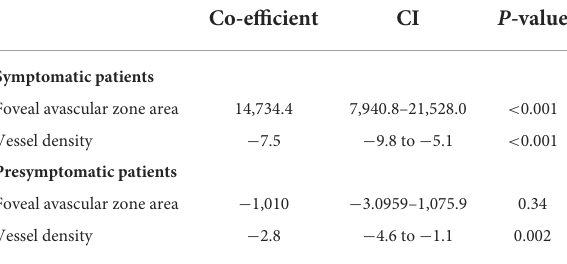
TABLE 2 Foveal avascular zone area and vascular density in RVCL-S patients vs. controls. Co-efficient